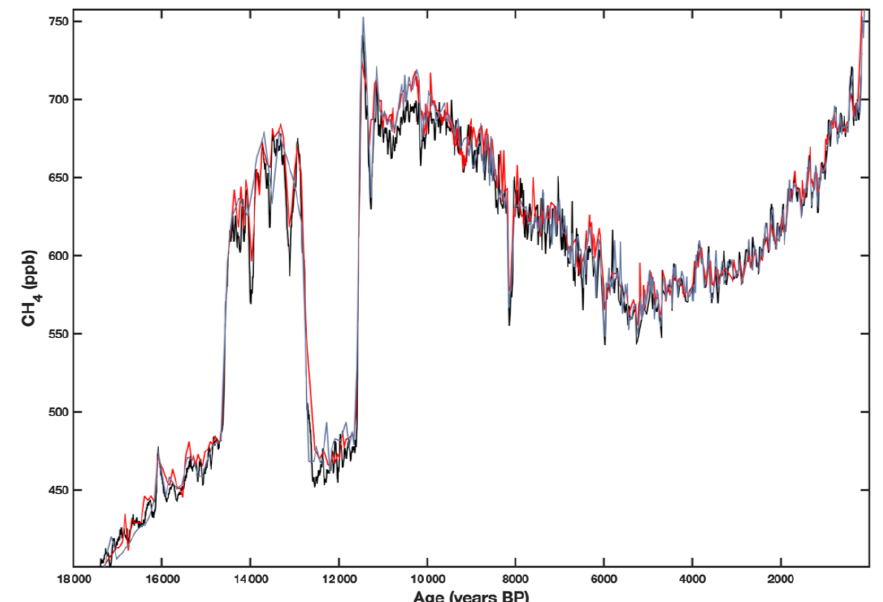
Figure 7. SPC14 (blue), WD (black), and RICE (red) all exhibit resolved centennial-scale variation in CH 4 in the Holocene and during the deglaciation. RICE data from Lee et al. (2020a); WD data from Rhodes et al.